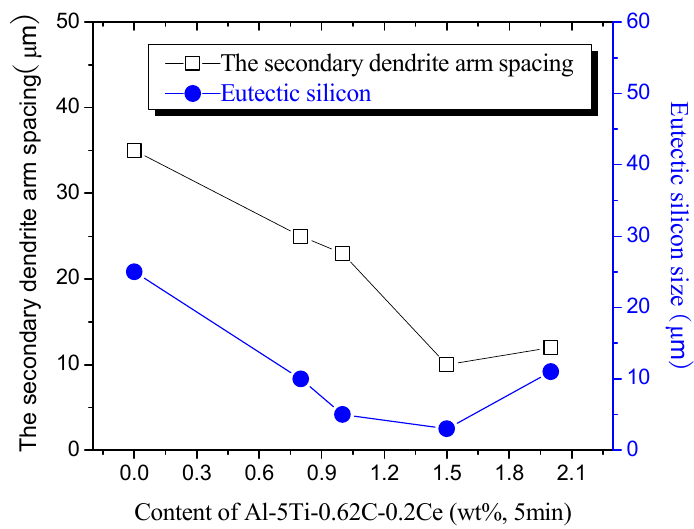
Figure 10. The relation curve between the content of Al-5Ti-0.62C-0.2Ce and the secondary dendrite arm spacing and eutectic Si in Al-8%Si alloy.